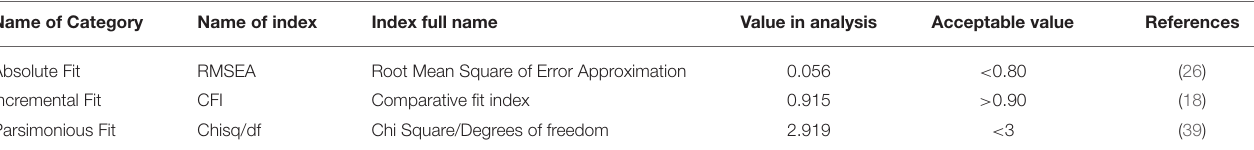
TABLE 6 | Structural equation modeling (SEM), model fitness